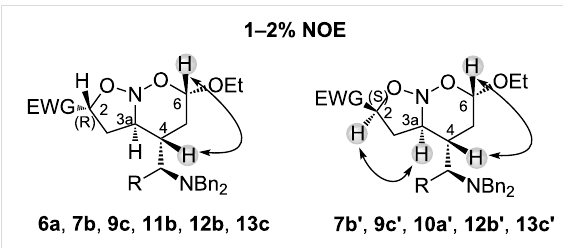
Figure 2: 1D NOESY correlation between H2, H3a, H4 and H6 for all nitroso